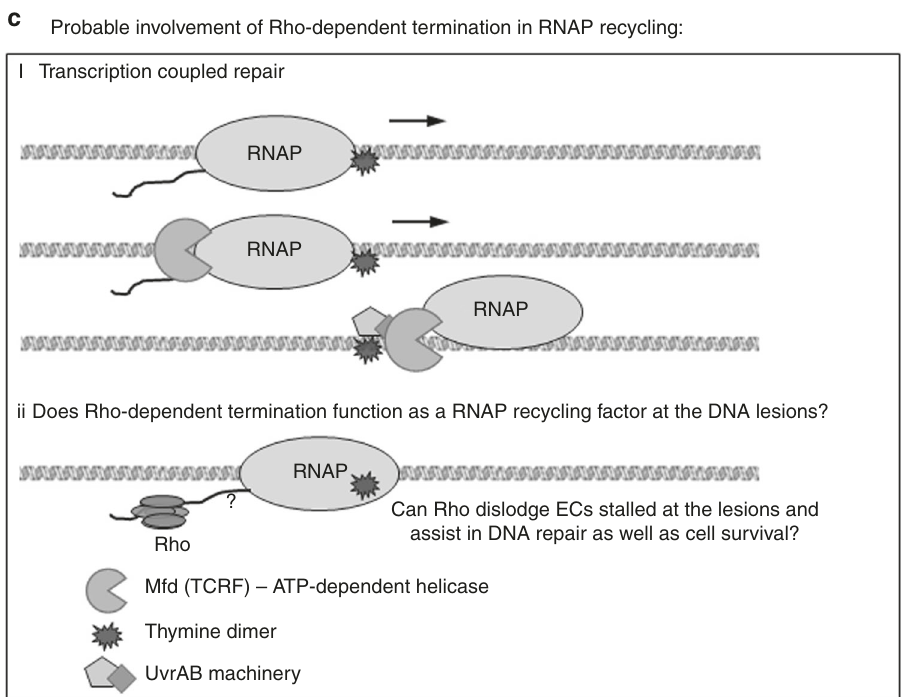
Fig. 1 Hypothesis of connecting Rho-dependent termination and NER : Cartoons depicting ( a ) operonic (transcription starting from the promotor region of a gene) and pervasive (transcription starting from other cryptic start sites) transcription. b RNAP as a global scanner for DNA damage: By virtue of the pervasive as well as the operonic transcriptions, RNAP could encounter the DNA lesions in a genome-wide fashion, and thus could act as a global sensor for the DNA damages. c Probable mode of invoking NER processes by Rho by displacing the stalled transcription elongation complexes at the lesions. In this regard, it resembles the RNAP-dislodging function of